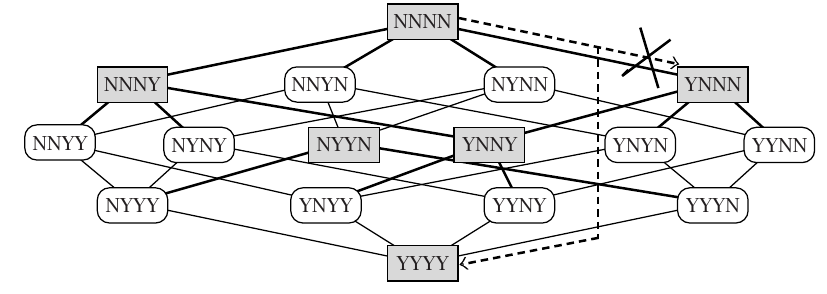
Figure 3.1 . The hypercube Q 4 has an asymmetric cover consisting of 6 asym- metric balls of radius 1, centered at the gray rectangular vertices; children of ball centers are connected upward to their respective parents by bold lines. In relaxing to a cover by 1-sets, the child of NNNN obtained from changing the first “N” to “Y” can be taken as YYYY instead of YNNN, yielding an optimal 1-set cover of size